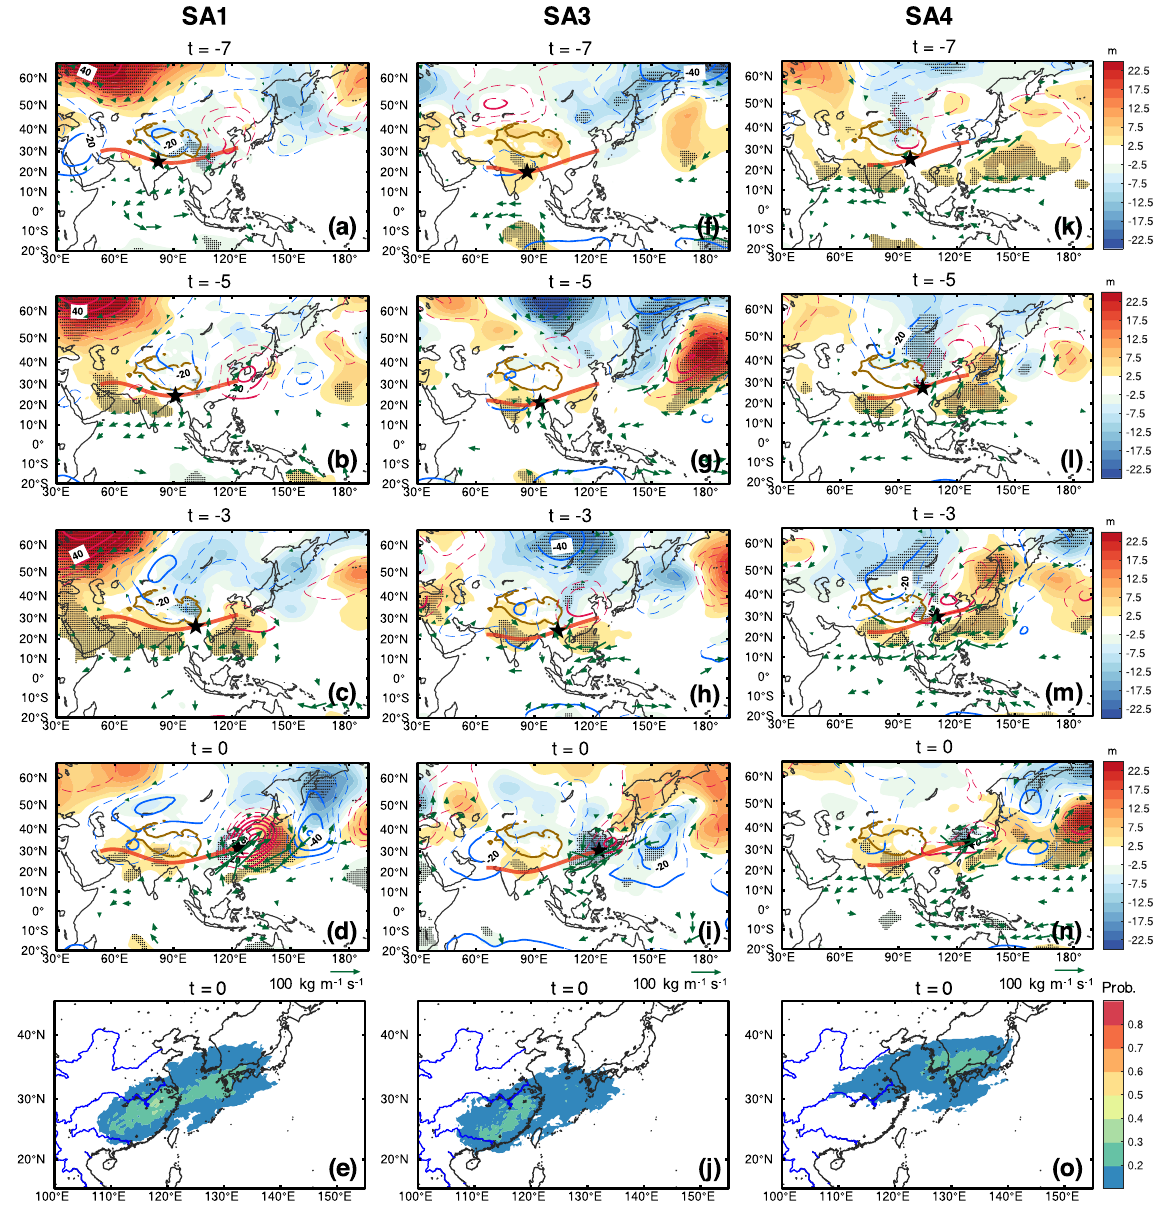
Fig. 3 Composites of meteorological fi elds within 2 weeks ahead of the clustered events fed by the SA1, 3 and 4 channels. a – e As in Fig. 2, but for SA1 (106 events), f – j SA3 (84 events), and k – o SA4 (129 events) on day − 7, − 5, − 3, and